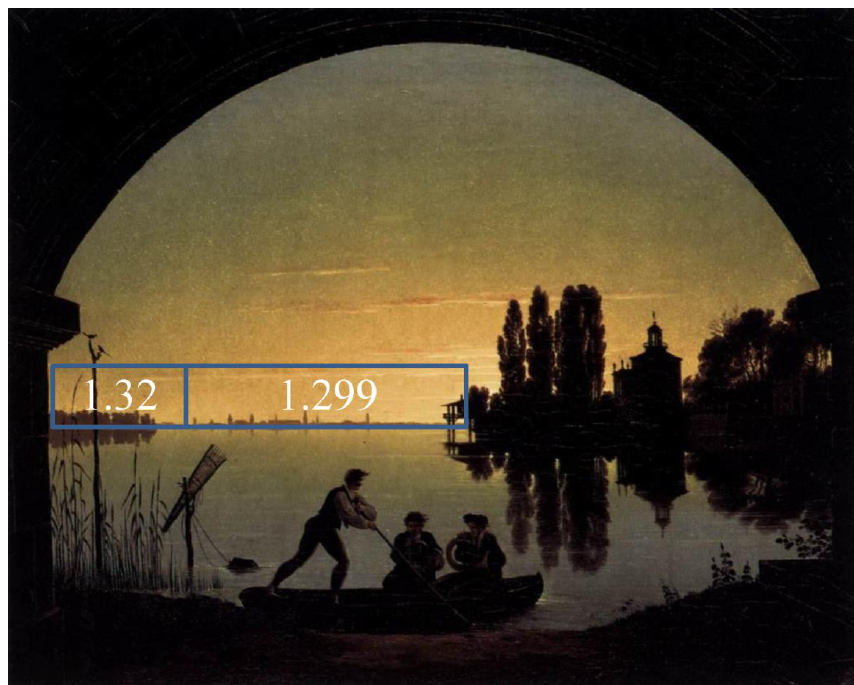
Fig. C2. Karl Friedrich Schinkel, The Banks of the Spree near Stralau, 1817. Corresponding R/G ratios were averaged inside each box.